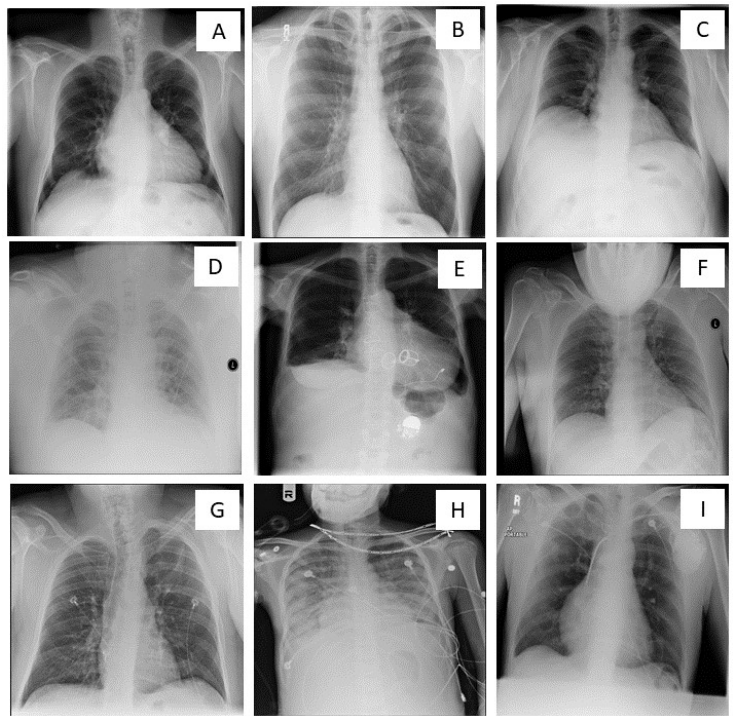
Figure 1. Optimal and suboptimal chest X-rays. ( A )—Optimal quality chest X-ray. Suboptimal chest X-rays ( B – I ) resulting from ( B )—non-inclusion of lung apices and costophrenic angles; ( C )—low lung volume/ inadequate inspiration; ( D )—under-exposure; ( E )—over-exposure; ( F )—chin overlying the lung fields; ( G )—patient rotation; ( H )—foreign body(necklace) overlying the lung field; ( I )—artifact in the lower part of the image obscuring part of left costophrenic angle. 3. Suboptimal CXRs: The Problem Poor quality exams not only affect the diagnostic interpretation but also have an economic impact. The national average cost of CXRs in the US is $ 420, with substantial variations across different locations and sometimes in the same region [8]. Given that 40% of the 3.6 billion worldwide imaging studies performed every year are CXRs, the cost